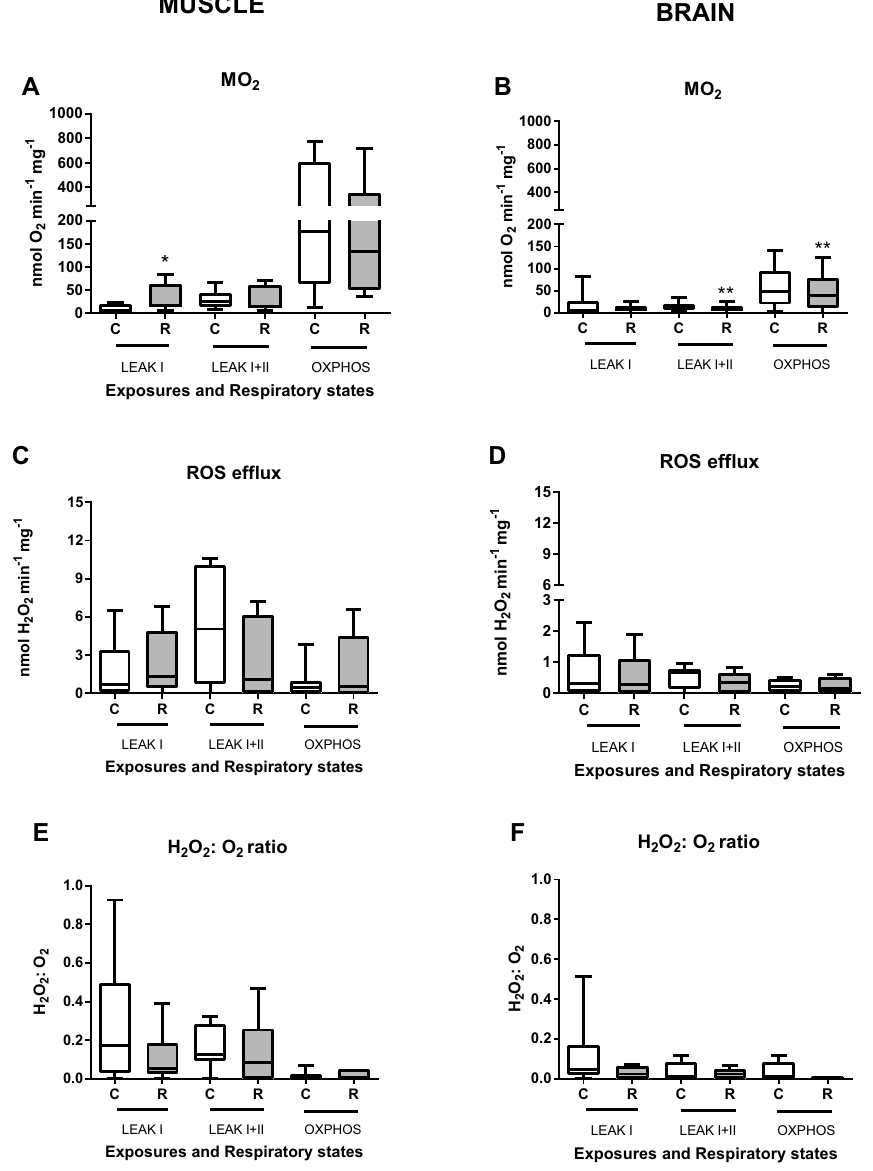
Figure 2. Effect of the H-R stress on the mitochondrial oxygen consumption ( Ṁ O 2 ) and ROS efflux rates in the permeabilized skeletal muscle and brain cells of S. scrofa. ( A , B ) oxygen consumption rates, ( C , D ) ROS efflux rates, ( E , F ) electron leak (the ratio of H 2 O 2 produced to O 2 consumed by the permeabilized cells). Conditions: C—normoxic (control) cells, R—cells after 15 min of severe hypoxia followed by 10 min of reoxygenation. Mitochondrial traits were measured in non-phosphorylating mitochondria in the presence of Complex I substrates (LEAK I), the mixture of Complex I and II substrates (LEAKI+II), and in the phosphorylating (ADP- stimulated) mitochondria respiring on the mixture of the Complex I and II substrates (OXPHOS). Asterisks indicate significant differences in the respective traits between the control and reoxygenation conditions (* P <0.05, ** P <0.01). N=6–7 for the skeletal muscle and 6 for the